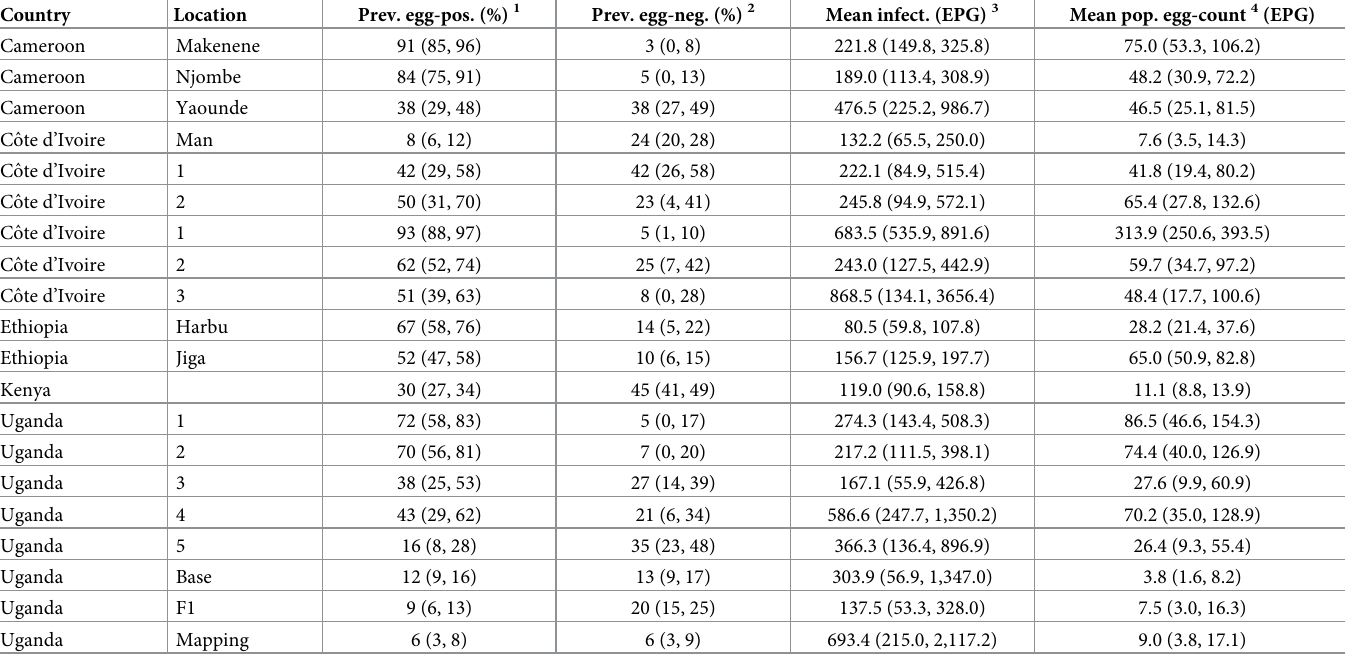
Table 4. Prevalence of egg-positive and egg-negative/antigen-positive cases and infection intensities for each dataset. Country Location Prev. egg-pos. (%)